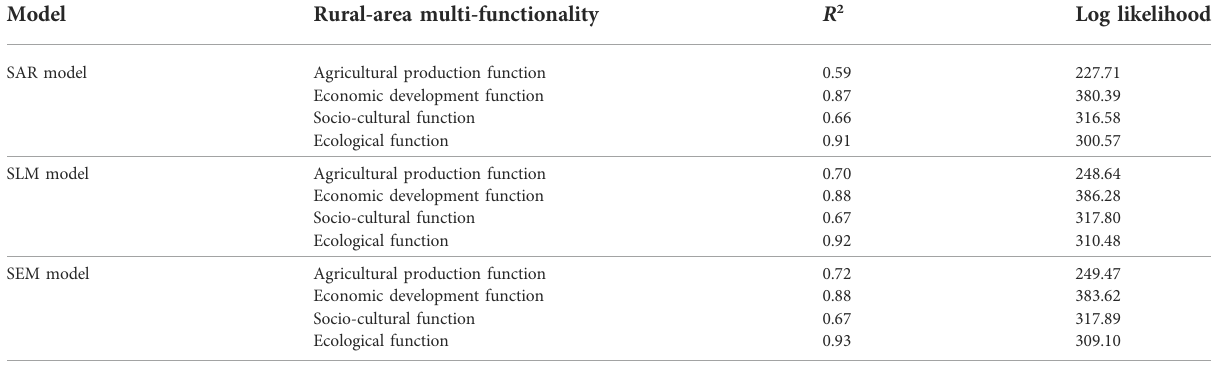
TABLE 4 Results of spatial econometric model fi tting.